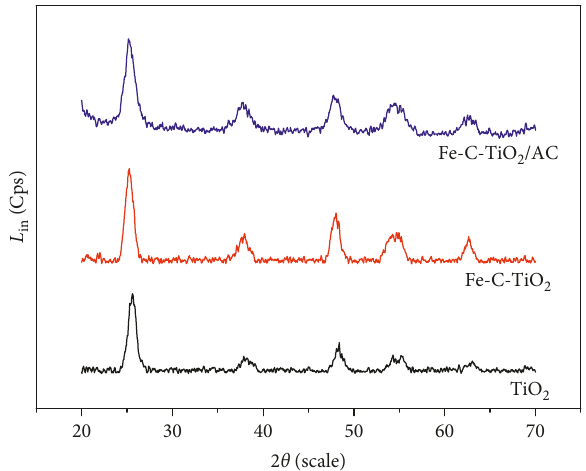
Figure 2: XRD patterns of Fe-C-TiO